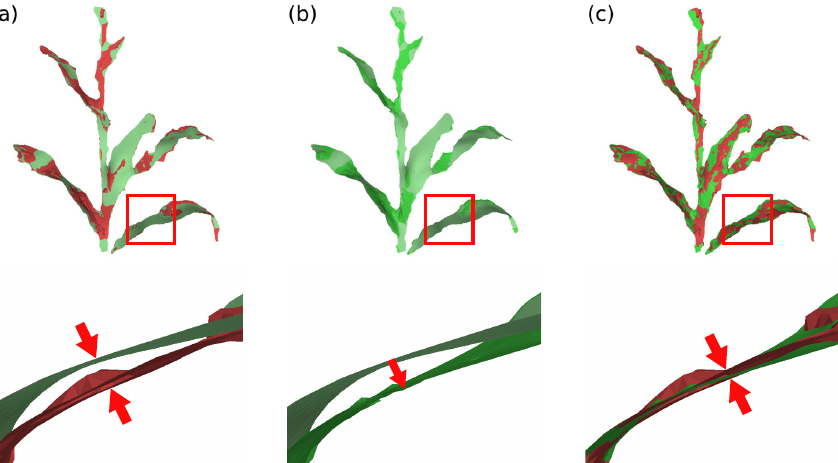
Figure 12. Model deformation in plant’s leaf region. ( a ) Difference of the plant’s leaf position between the model deformation graph (green) and the input surface deformation graph (red), during processing between frames 40 and 50; ( b ) deformation of the model surface and ( c ) comparison between deformed model surface (green) and input surface